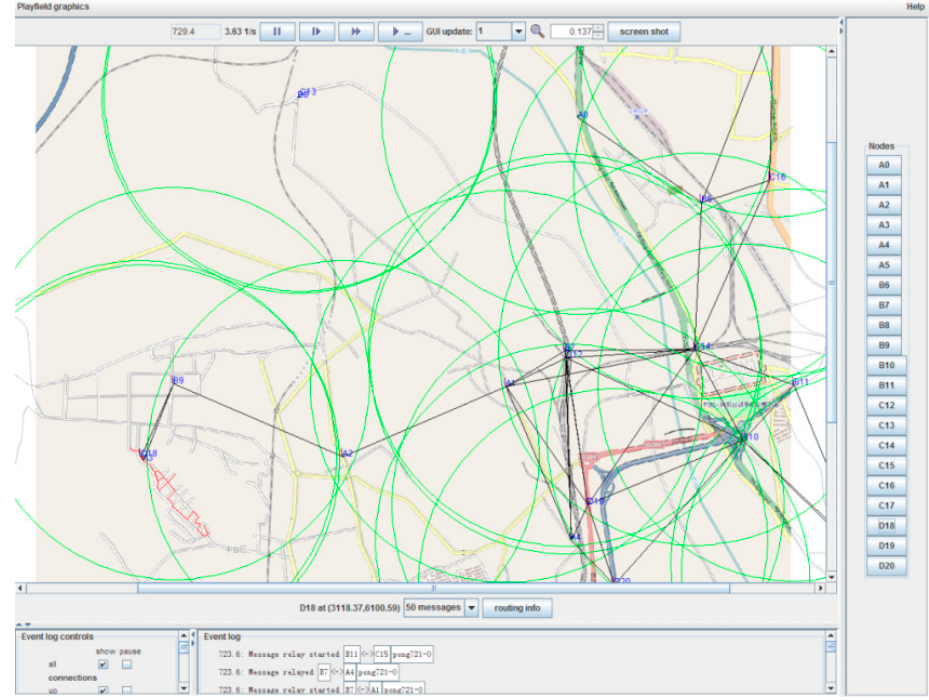
Figure 12. Operation results of the simulation system.